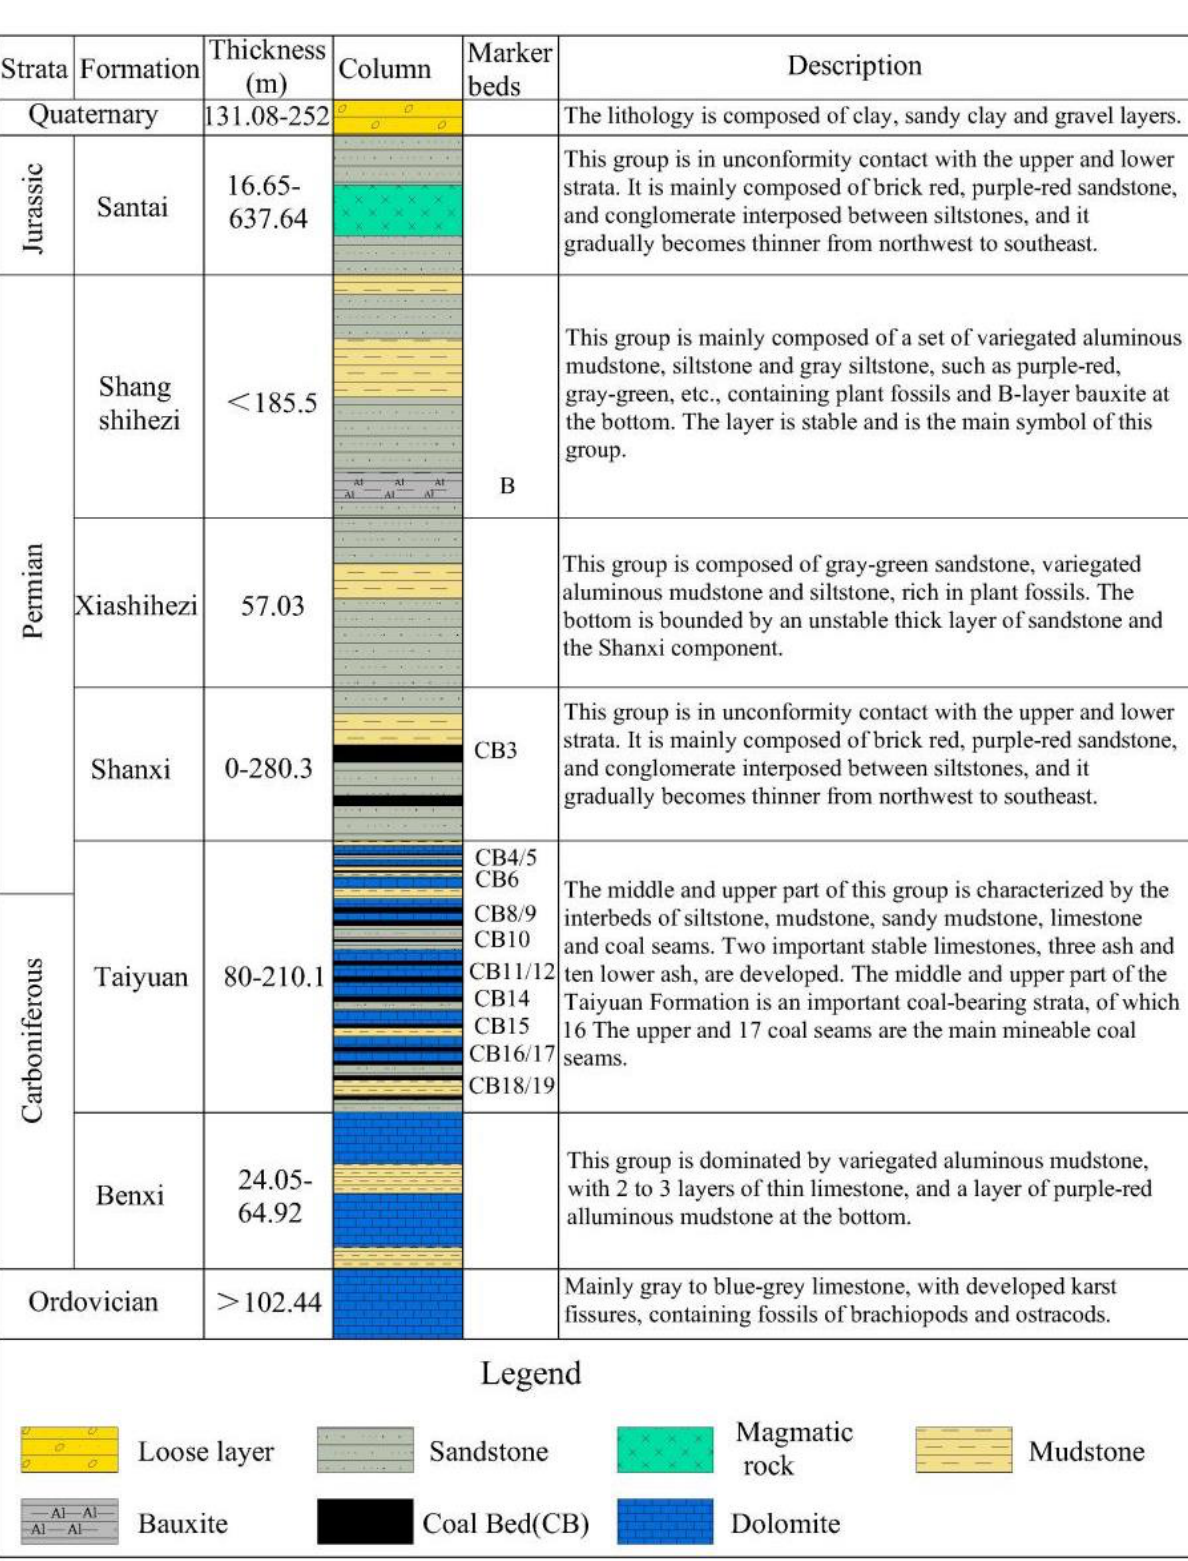
Figure 2. Stratigraphic column.